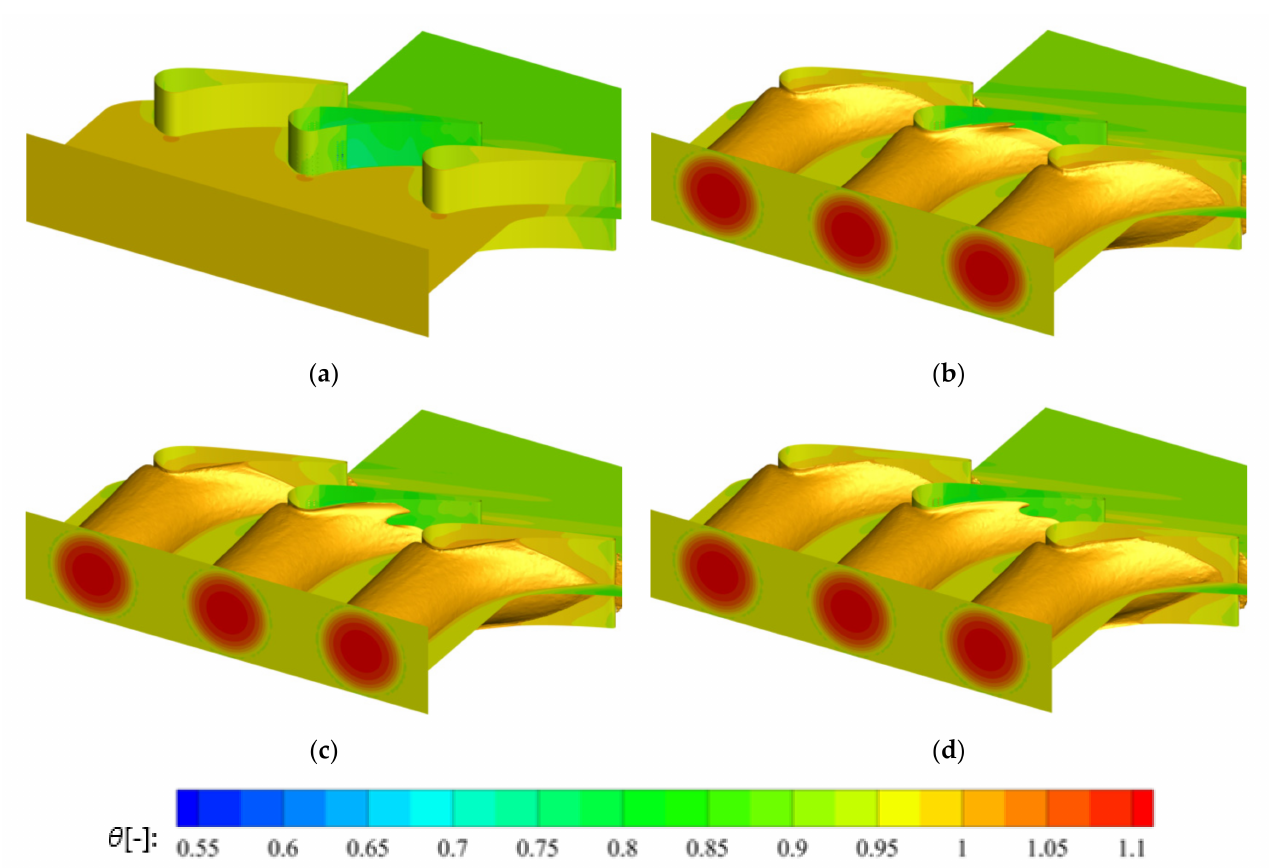
Figure 8. Stretching of hot streak core for different cases. ( a ) Case 1: uniform inlet; ( b ) Case 2: HS only; ( c ) Case 3: HS and positive swirl; ( d ) Case 4: HS and negative